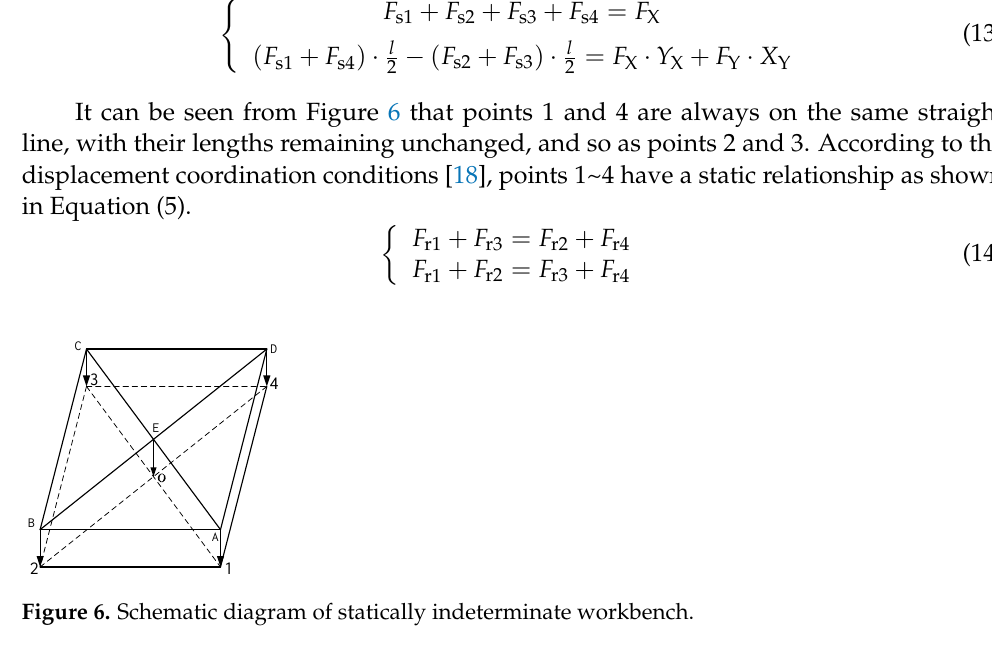
guide rail pair in the lateral direction can be obtained, as shown in Equation